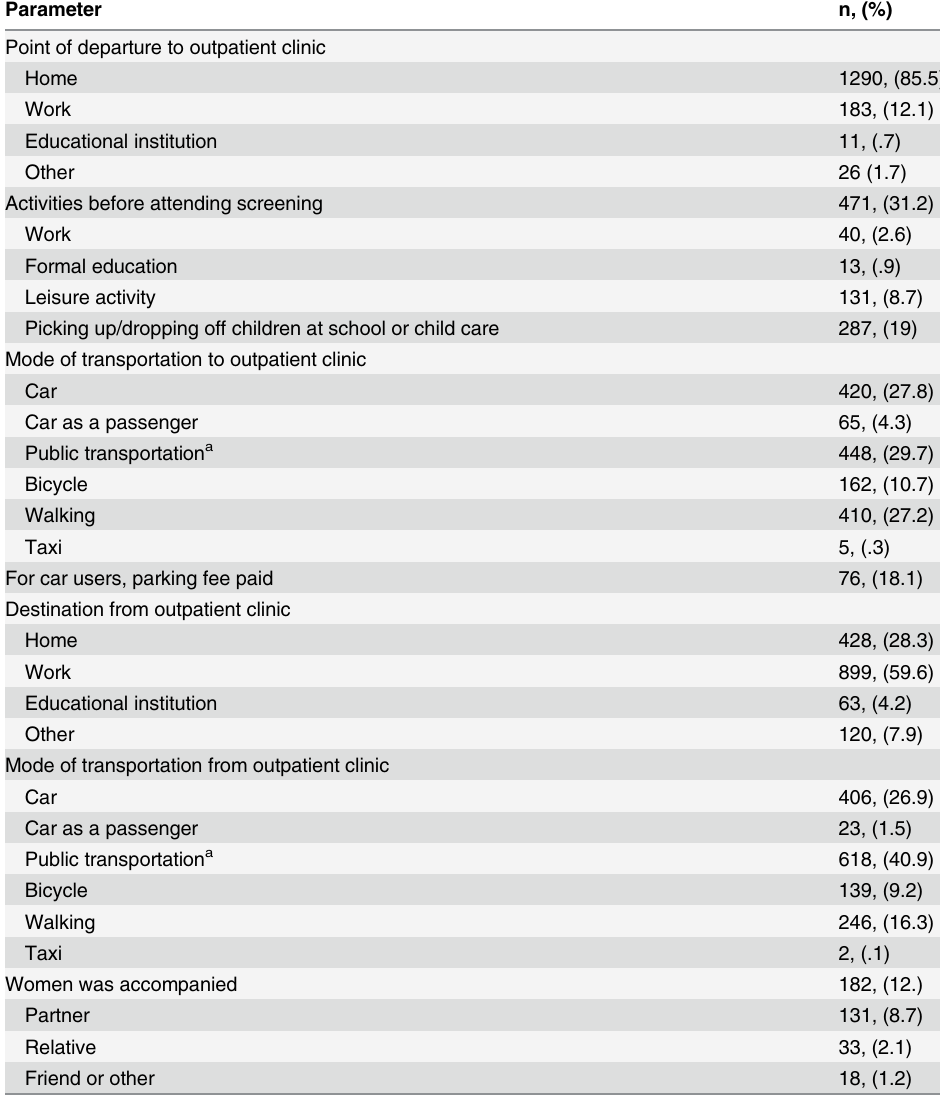
Table 2. Travel characteristics of 1510 women attending the clinic-based cervical cancer screening program in Sweden. Parameter n, (%) Point of departure to outpatient